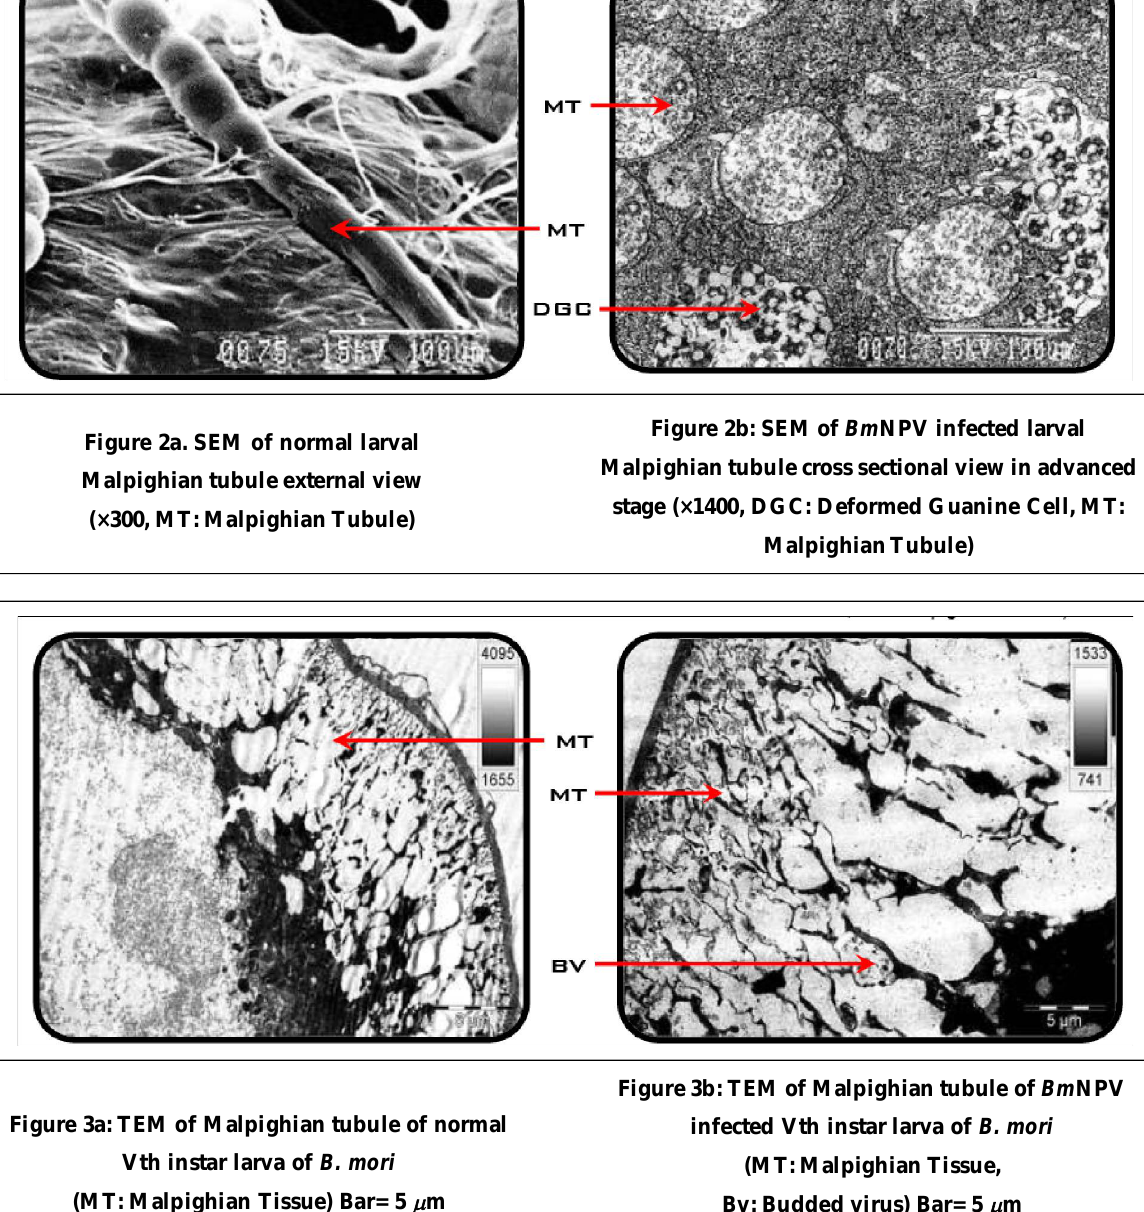
Figure 3b: TEM of Malpighian tubule of Bm NPV infected Vth instar larva of B. mori (MT: Malpighian Tissue, Bv: Budded virus) Bar= 5 